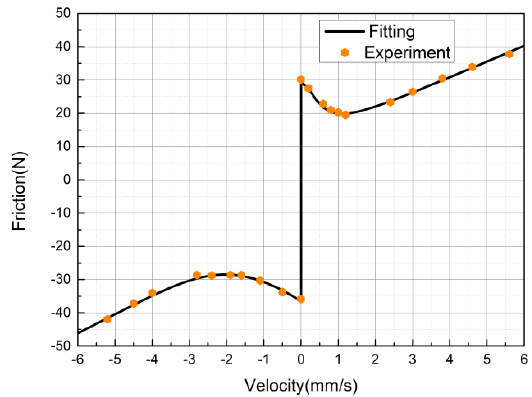
Figure 15. Friction fit graph.